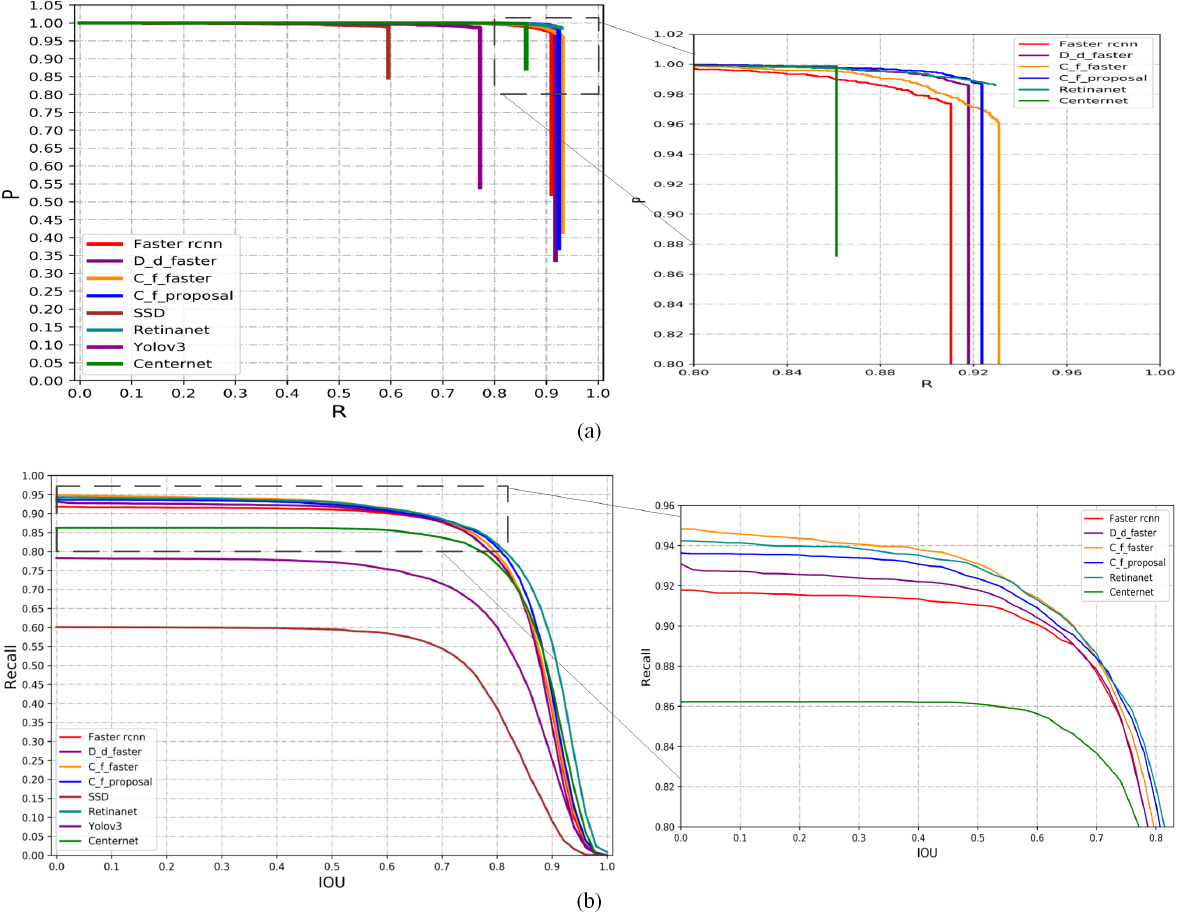
Figure 10. P-R curves ( a ) and recall-IOU curves ( b ) with zoomed parts of the proposed and compared methods and a series of detection methods. The proposed method shows competitiveness in all the zoomed